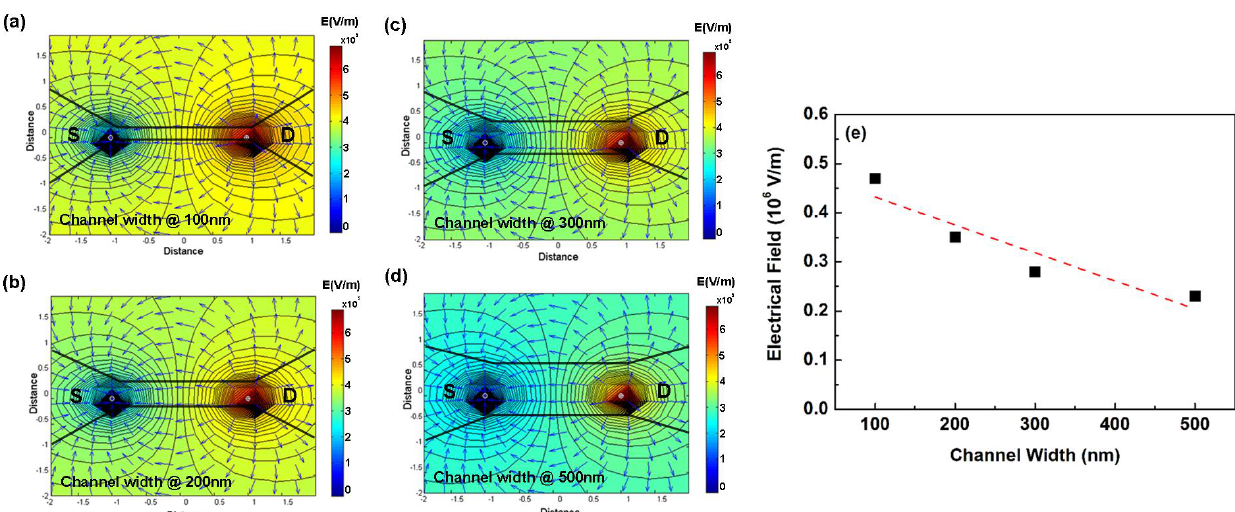
Figure 10. Channel electrical field simulation for the PSWs with channel widths of (a) 100 nm, (b) 200 nm, (c) 300 nm, and (d) 500 nm. (e) is the linear fitting of the electrical field strength for the corresponding